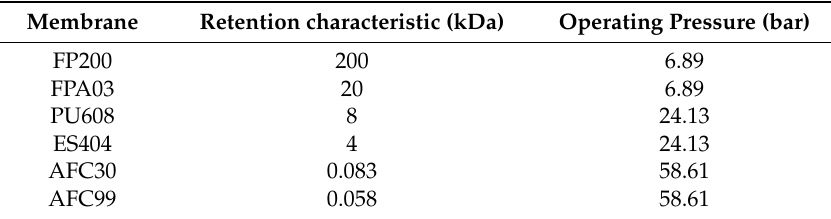
Table 3. Operation pressures of the various membranes used.